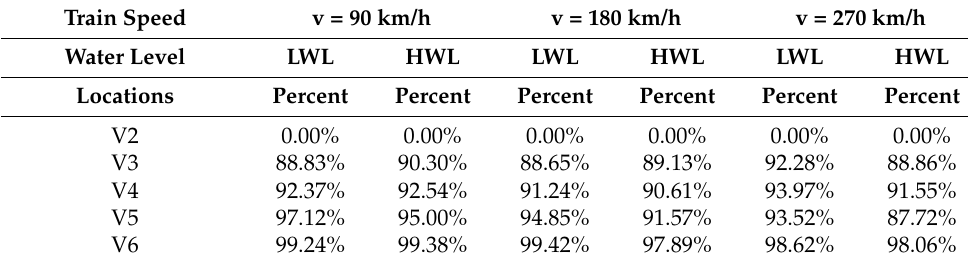
Table 3. Peak velocity decrease percent in horizontal